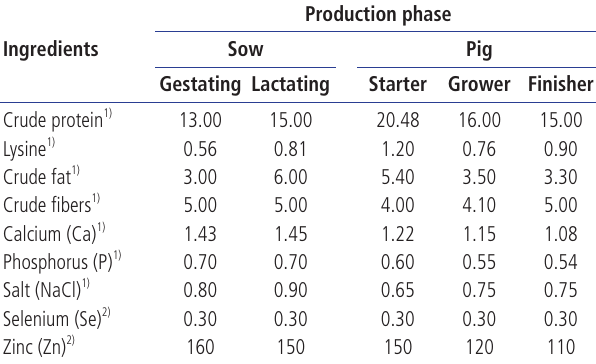
Production phase